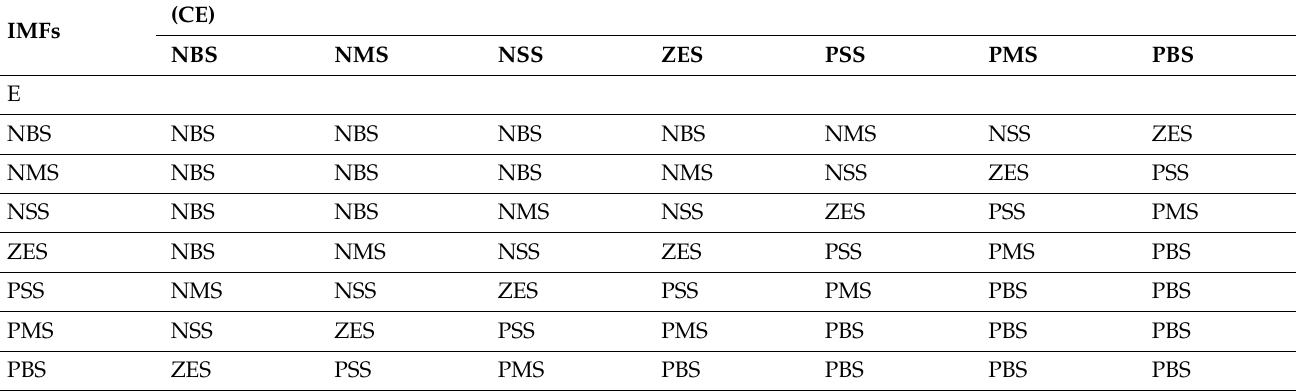
Table 2. Fuzzy rules with relationships between IMFs and OMFs.